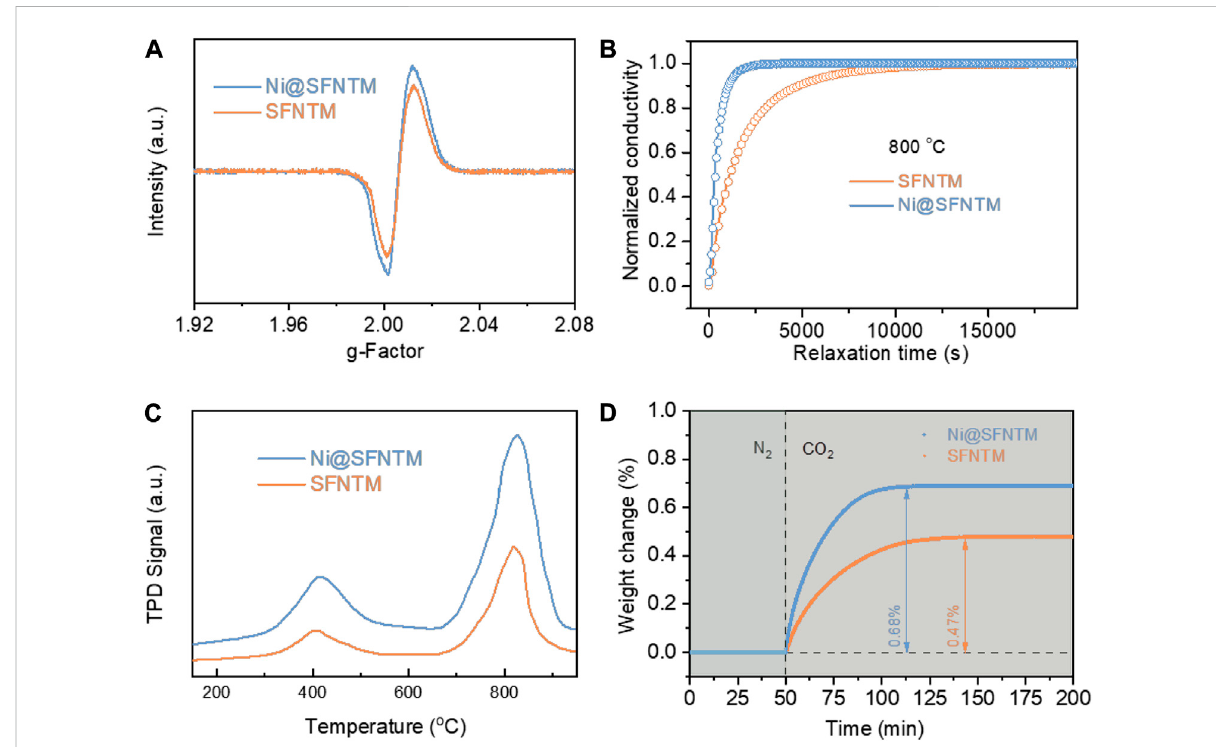
FIGURE 4 (A) EPR measurements and (B) ECR curves of SFNTM and Ni@SFNTM samples, (C) CO atmosphere from 2:1 CO-CO 2 to 1:1 CO-CO 2 , (D) Thermogravimetric relaxation curves on changing test gas from N 2 to CO 2 at 600 °